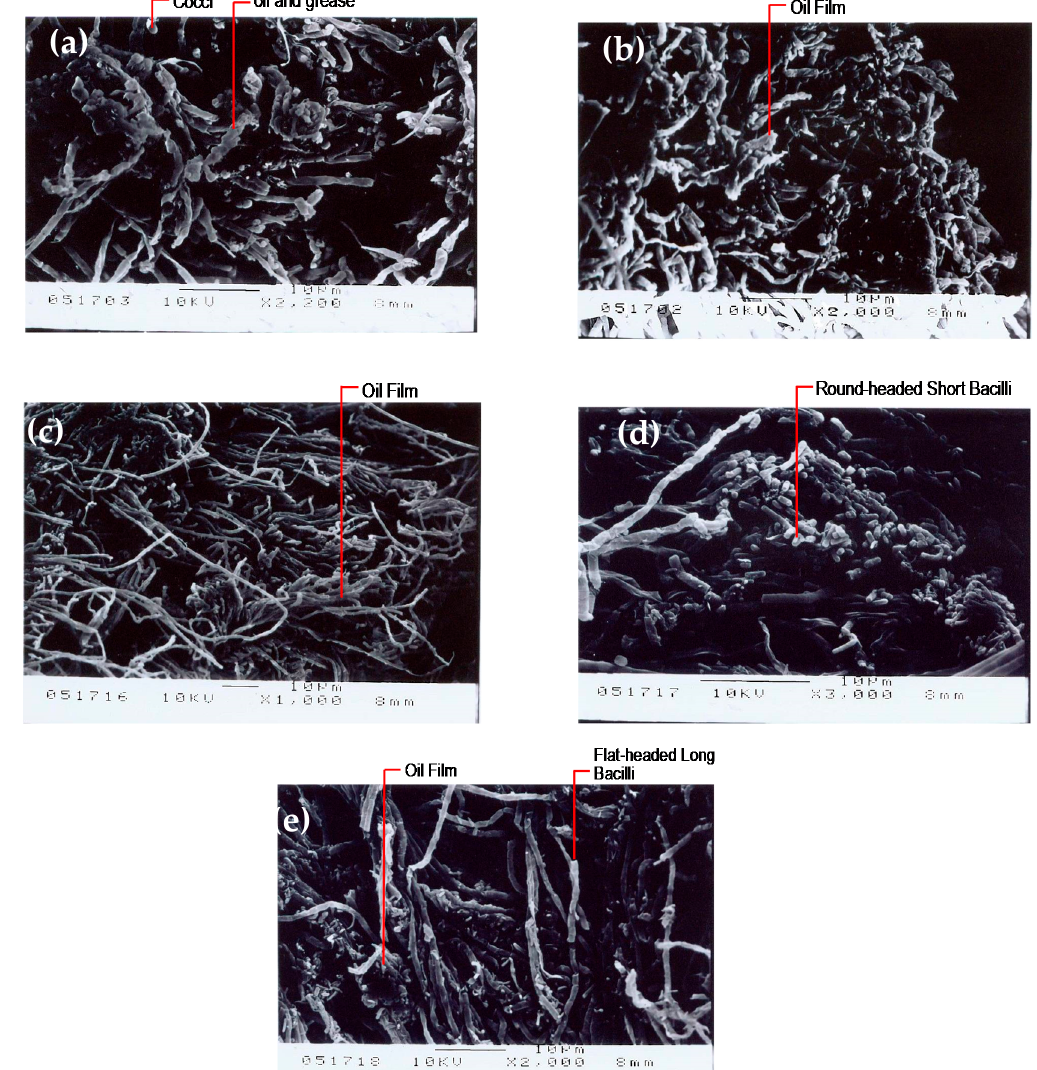
Figure 9. ( a ) Biological phase of first tank in AS system following addition of 120 mg/L of oil and grease; ( b ) biological phase of second tank in AS system following addition of 120 mg/L of oil and grease; ( c ) biological phase of first tank in AS/CA system following addition of 120 mg/L of oil and grease; ( d ) suspended biological phase of second tank in AS/CA system following addition of 120 mg/L of oil and grease; ( e ) fixed biological phase of second tank in AS/CA system following addition of 120 mg/L of oil and grease.